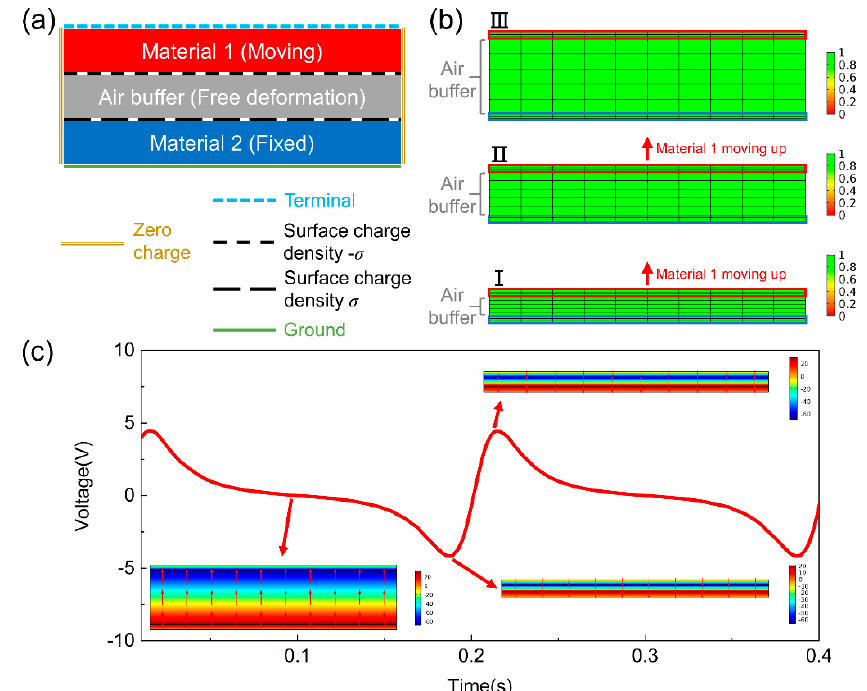
Figure 2. ( a ) Boundary conditions for contact mode TENG. ( b ) Mesh remains best quality when contact mode TENG is moving from state I to III. ( c ) The voltage potential distribution and the dynamic voltage output under a 10-M Ω external load.